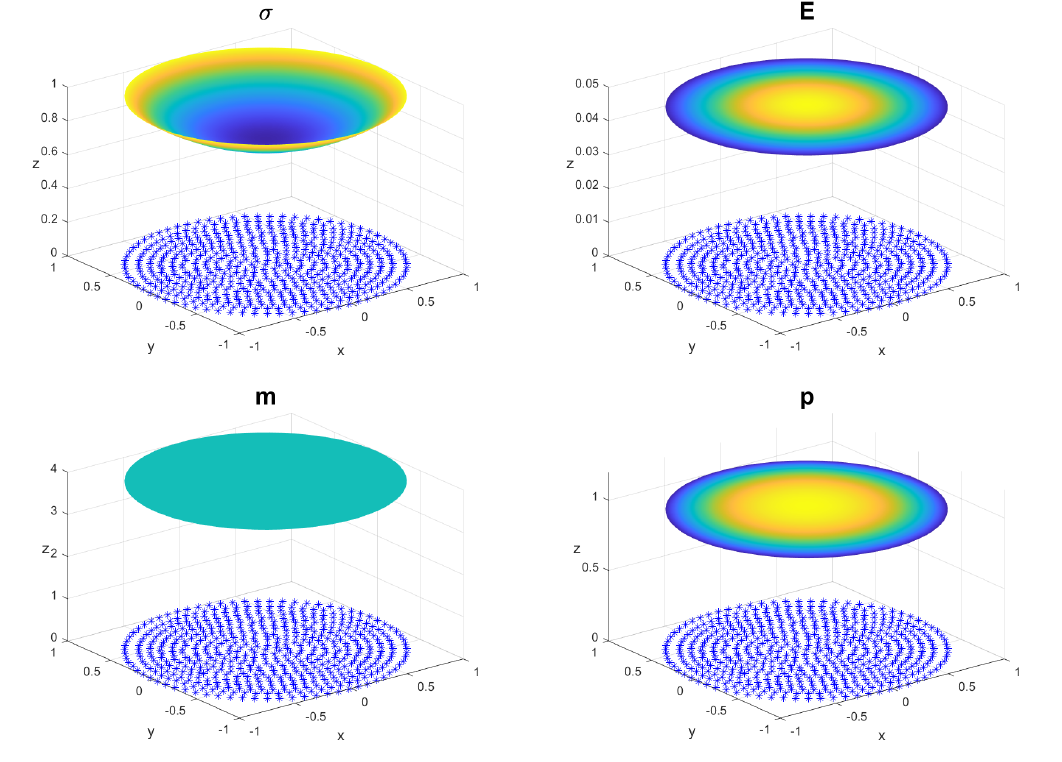
Figure 9. Graphs of the functions: σ , E , m and p for t = 5